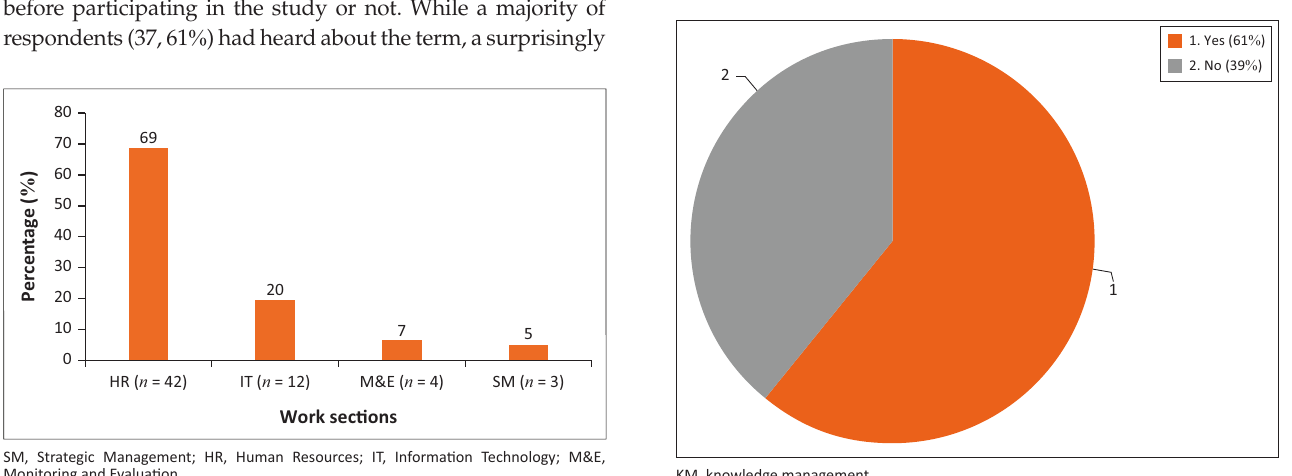
FIGURE 2: Prior awareness of knowledge management ( N = 61). FIGURE 1: Sections respondents currently working under ( N =